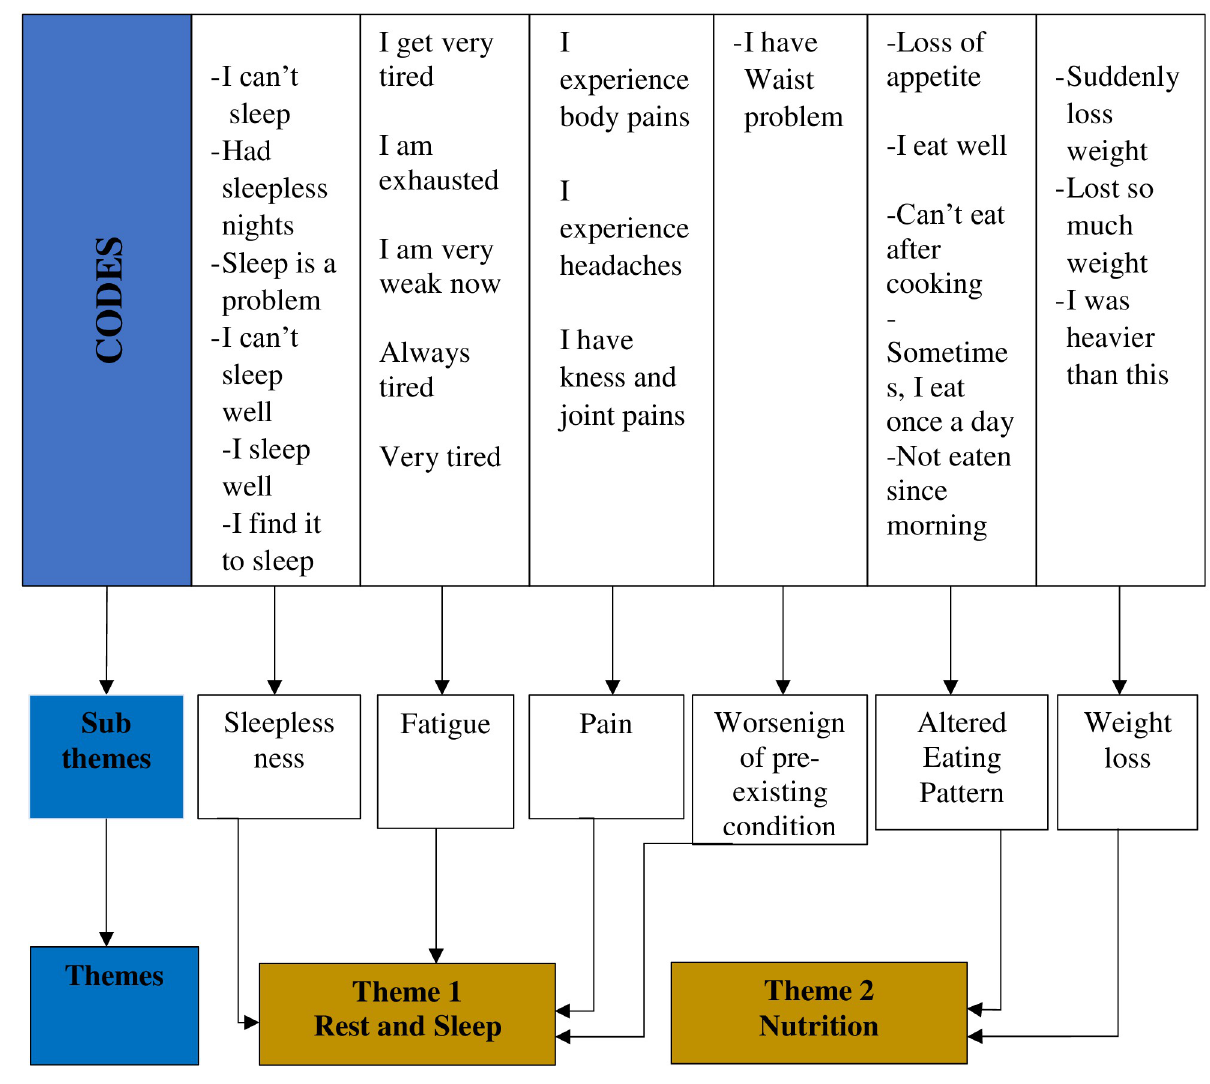
Fig 1. Coding tree for the physical impact of